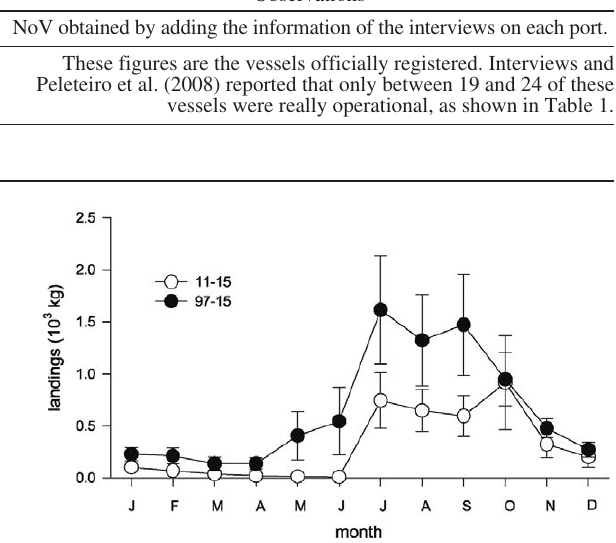
Table 2. – Number and main characteristics of the vessels per fishing gear which yielded squid landings in the three areas over the study period. HJB, hand-jig from boat; Boliche, beach seine; BS, boat seine; GRT, gross register tonnage; HP, horse power. Fishing gear